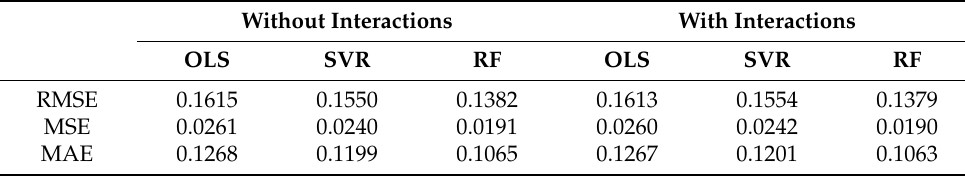
Table 7. Comparison of the three prediction